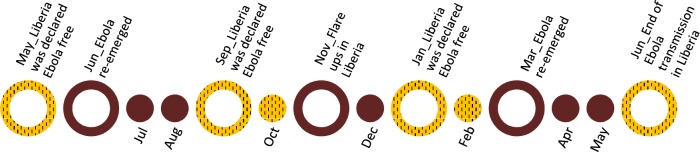
Timeline May 2015 until June 2016 [49].